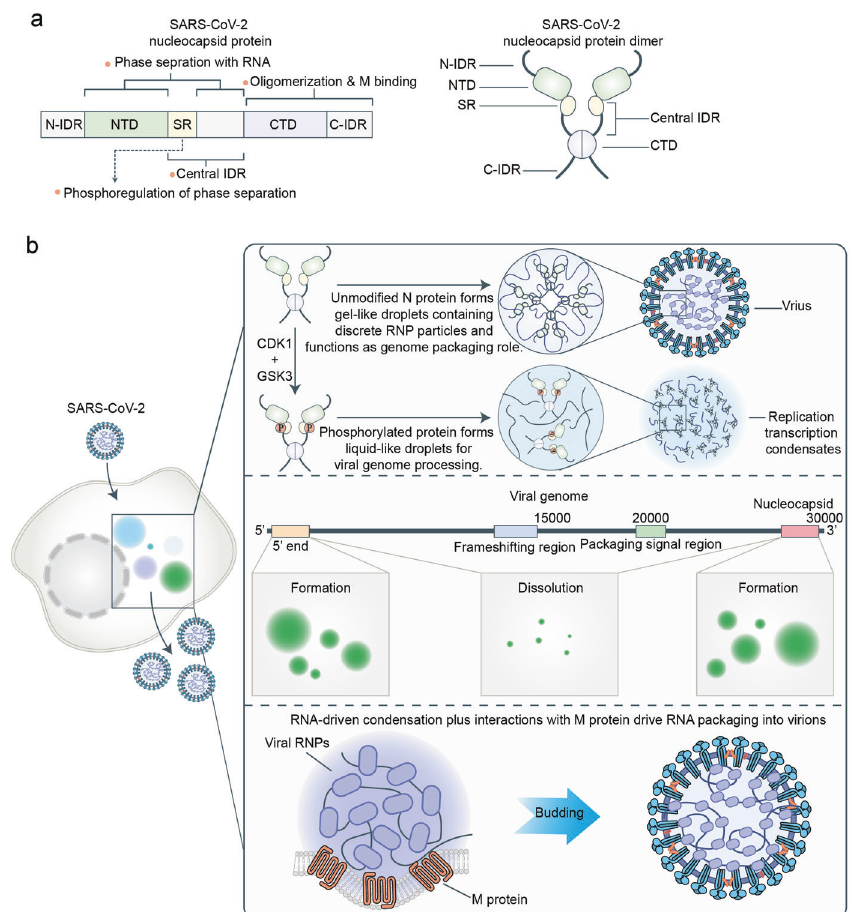
Fig. 9 LLPS in SARS-CoV-2 infection. a Nucleocapsid (N) protein contains an N-terminal intrinsically disordered region (N-IDR), a structured N- terminal domain (NTD), a central intrinsically disordered region (central-IDR), a structured C-terminal domain (CTD), and a C-terminal intrinsically disordered region (C-IDR). Of these, NTD and central-IDR play an important role in the phase separation of N protein with RNA. b LLPS plays an important role in SARS-CoV-2 infection. The central-IDR contains a conserved serine-arginine (SR)-rich sequence. Unmodi fi ed N protein forms gel-like condensates containing discrete ribonucleoprotein (RNP), which is conducive to its function of genome packaging roles. After being phosphorylated by cyclin-dependent kinase-1 (CDK1) and glycogen synthase kinase-3 (GSK3) in the SR region, N protein forms liquid-like condensates for viral genome processing. Viral RNA sequence and structure in speci fi c genomic regions are also involved in the regulation of the N protein phase separation. The speci fi c regions of the viral RNA genome, including a region spanning the 5 ’ end ( fi rst 1000 nt) and a region-encoded N protein at the 3 ᾽ end, can promote the phase separation of N proteins, whereas most regions in the genome facilitate the dissolution of N protein condensates. The viral membrane (M) protein can independently form condensates with N protein. During the late stages of SARS-CoV-2 infection, the viral RNP condensates will interact with the soluble CTD of M protein to form two-layered condensates, which promote the SARS-CoV-2 virion assembly separation. Recent evidence from Christiane et al. indicates that (N-IDR), a structured N-terminal domain (NTD), a central intrinsi- the speci fi c regions of the viral RNA genome, including a region cally disordered region (central-IDR), a structured C-terminal spanning the 5 ᾽ -end ( fi rst 1000 nt) and a region encoding the 3 ᾽ - domain (CTD), and a C-terminal intrinsically disordered region end of the N protein can promote the phase separation of N (C-IDR) (Fig. 9a). 184 Of these, the NTD and central-IDR play an protein, whereas most other regions in the genome facilitate the important role in the phase separation of the N protein with dissolution of N protein condensates (Fig. 9b). 34 The balance RNA. 36 Moreover, the central-IDR contains a conserved serine- arginine (SR)-rich sequence. 185,186 Unmodi fi ed N protein forms between phase separation-promoting and solubilizing regions in the viral RNA genome may be bene fi cial for N proteins to package gel-like condensates containing discrete ribonucleoprotein (RNP), the viral genome. In addition to RNA, the transmembrane M which is conducive for its genome packaging roles. After being protein can also independently form condensates with N protein phosphorylated by cyclin-dependent kinase-1 (CDK1) and glyco- (Fig. 9b). 32 The interactions between the soluble CTD of M protein gen synthase kinase-3 (GSK3) in the SR region, the N protein forms liquid-like condensates for viral genome processing (Fig. 9b). 38 and the C-IDR of N protein mediates this process. Interestingly, when adding RNA to the condensates, which are formed by M Therefore, phosphorylation of the SR region regulates the distinct protein and N protein, it will form two-layered condensates with a functions of the N protein in genome packaging and processing central core of N protein + RNA surrounded by a shell of N by transforming the material properties of the N protein protein + M protein. 32 These results suggest that during the late condensates from gel-like to liquid-like. In addition to phosphor- ylation, the viral RNA sequence and structure in speci fi c genomic stages of SARS-CoV-2 infection, the viral RNP condensates will regions are also involved in the regulation of the N protein phase interact with the soluble CTD of the M protein to form a two-